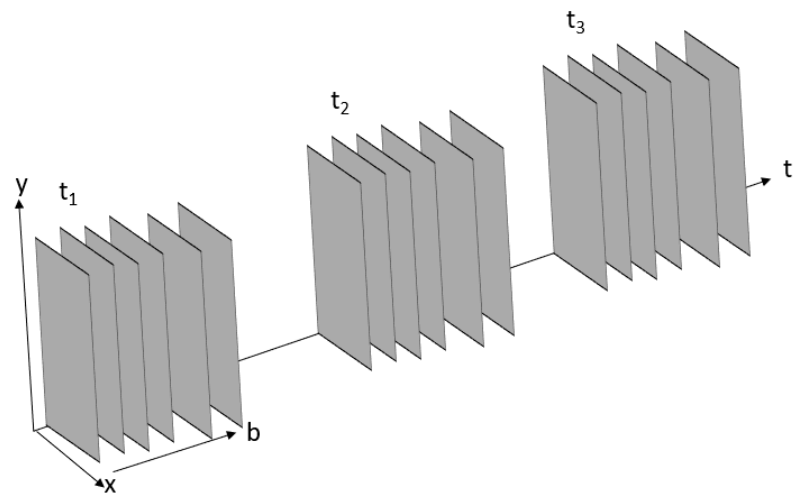
Figure 1. Spatial data model of the NetCDF data format (x = latitude, y = longitude, b = spectral bands (thematic layers) and t = time).